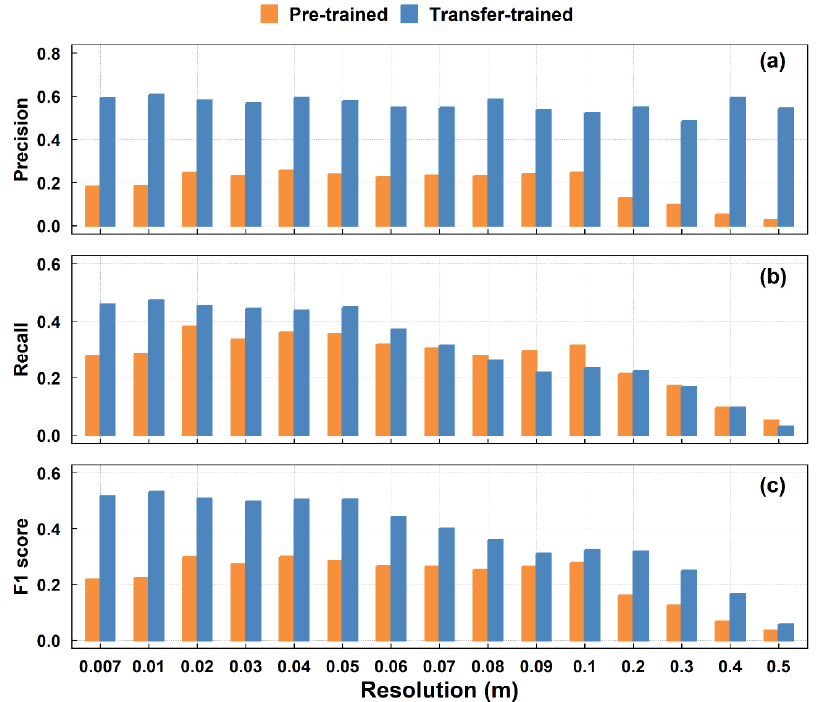
Figure 5. The effects of spatial resolution in the evaluation of tree crown detection from UAV-based RGB imagery using the pre- and transfer-trained DeepForest methods as illustrated by the precision ( a ), recall ( b ), and F1 score ( c ).